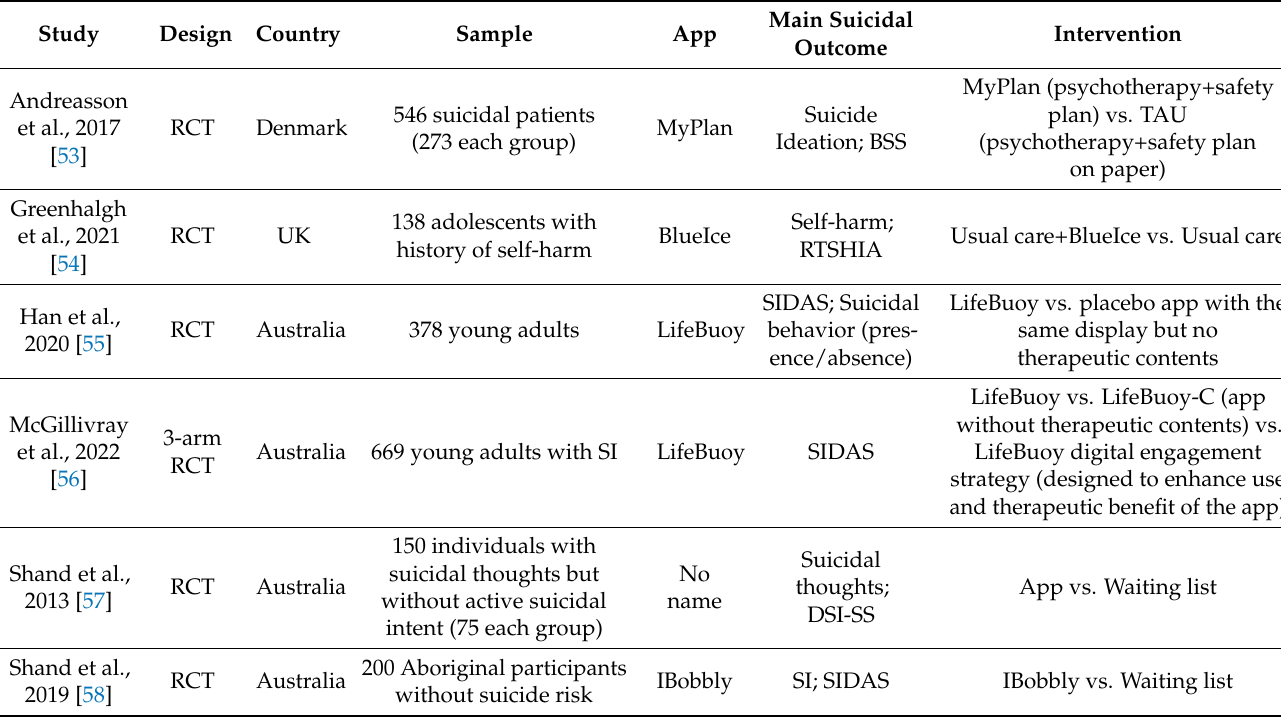
Table 4. Protocols of studies not yet